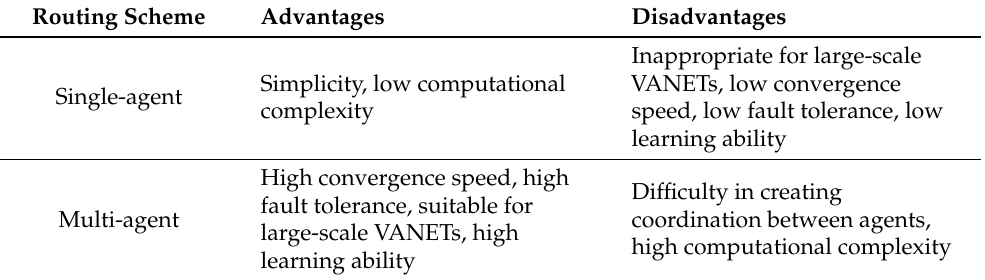
Figure 4. A multi-agent system. Table 3. Single-agent and multi-agent